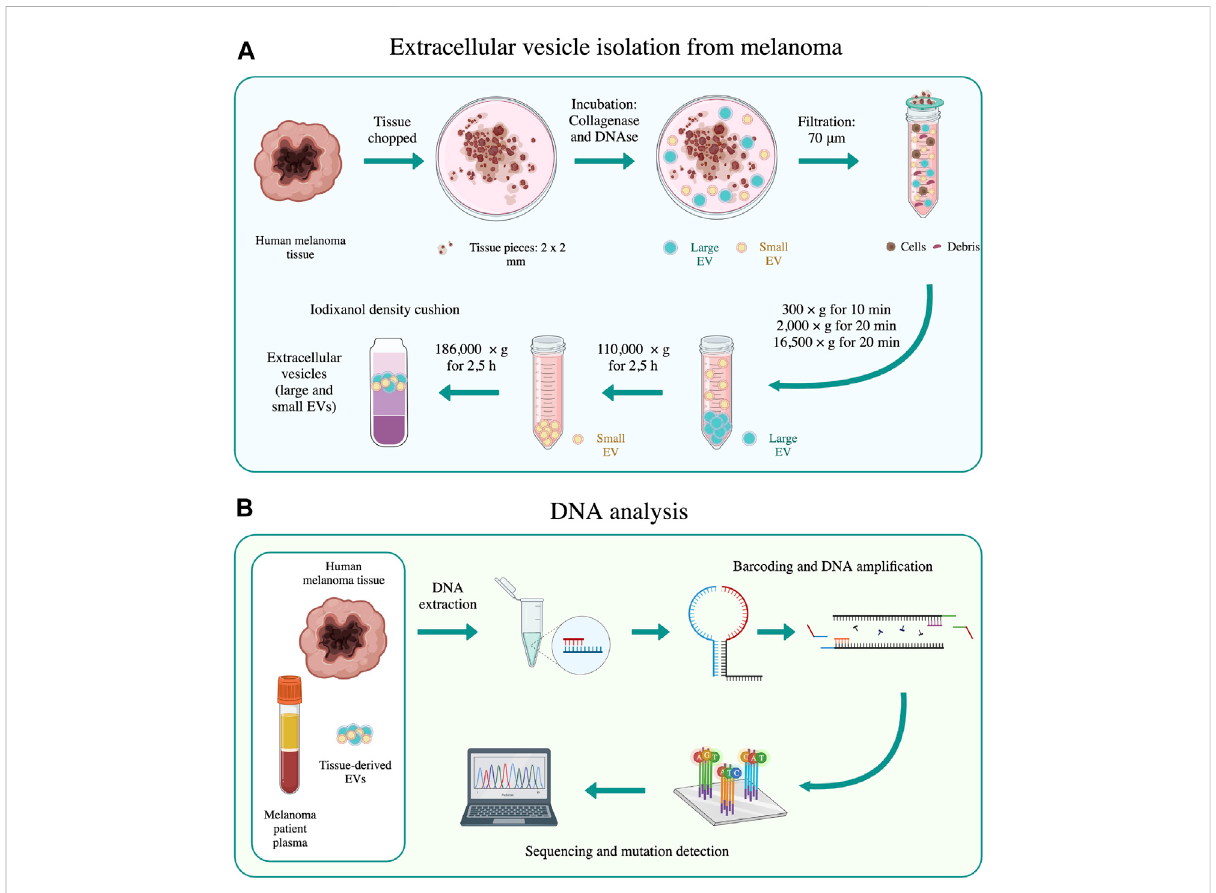
FIGURE 1 Schematic representation of the main methods used in this work. (A) EV isolation from melanoma tissues was performed according to the method of Crescitelli et al. (Crescitelli et al., 2021). (B) DNA sequencing was performed on human melanoma tissue, tissue-derived EVs, and melanoma patient plasma using SiMSen-Seq analysis, as described by Ståhlberg et al. (Ståhlberg et al., 2017). The schematic was created with biorender.com.